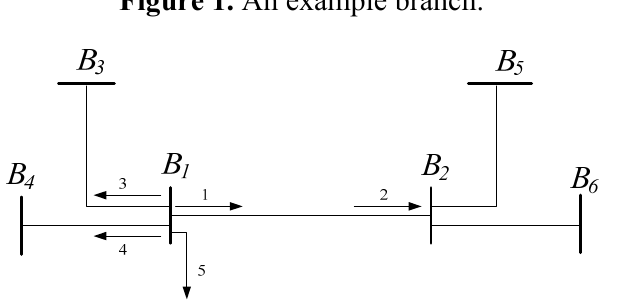
Figure 1. An example